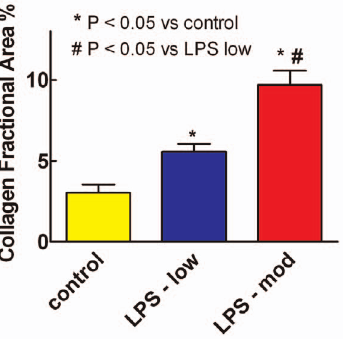
Figure 7. LPS dose-dependently increased percent collagen fraction area of the left ventricle. Percent collagen fraction area (mean + SEM) measured by picrosirius staining of the left ventricle increased 12–15 weeks after weekly i.p. injections of low dose LPS (0.5 6 0.1 mg/kg, n=15) or moderate dose LPS (12 6 1 mg/kg, n=15) compared with saline (control, n=17) (P , 0.001, one way ANOVA). There was a greater increase with moderate dose LPS than with low dose LPS (P , 0.05).